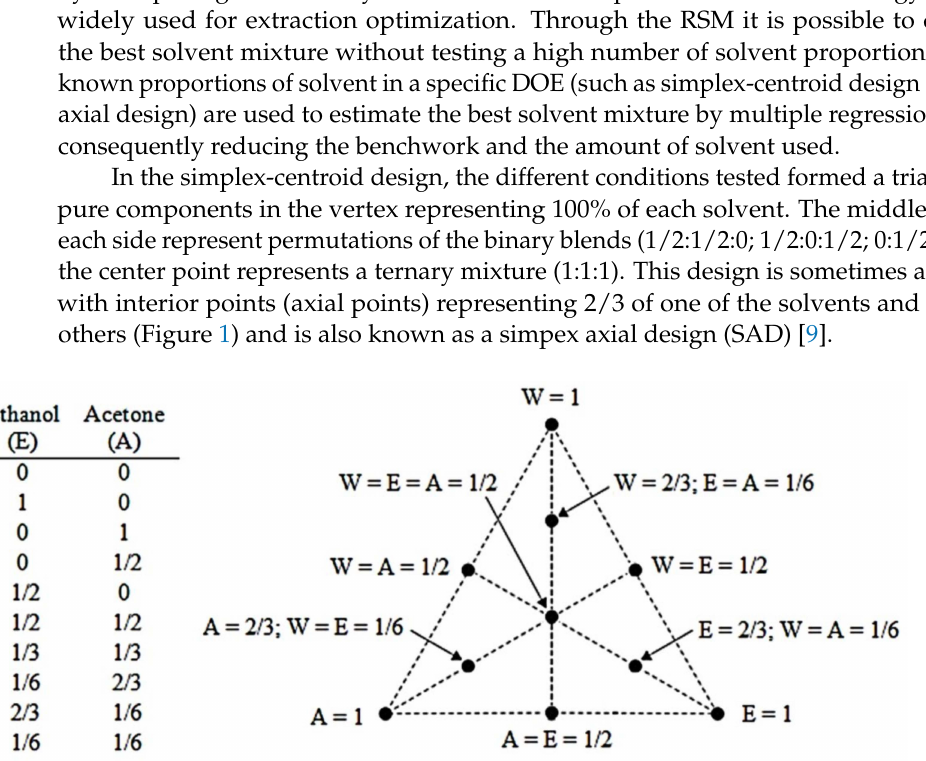
Figure 1. Illustration representing the mixture design simplex axial design (SAD). W—water, E—ethanol,